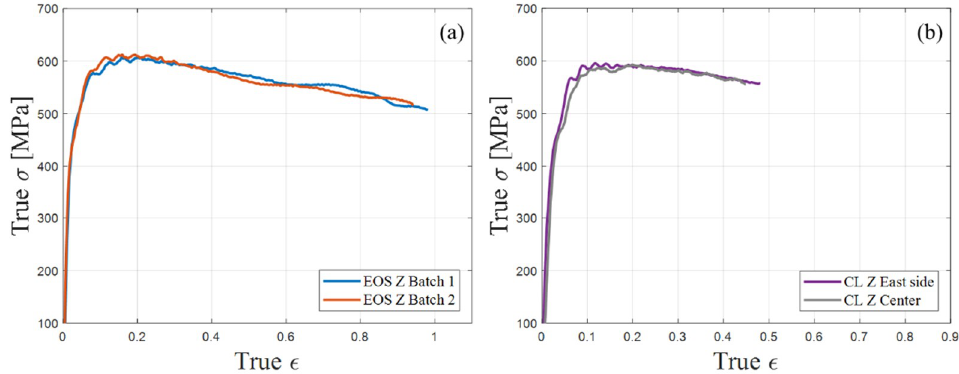
Figure 5. Presentation of the repeatability by comparing, ( a ) 2 EOS‘s Z-orientation samples from deferent batches and, ( b ) CL’s Z orientation samples located at the center and in the east side of the building platform.